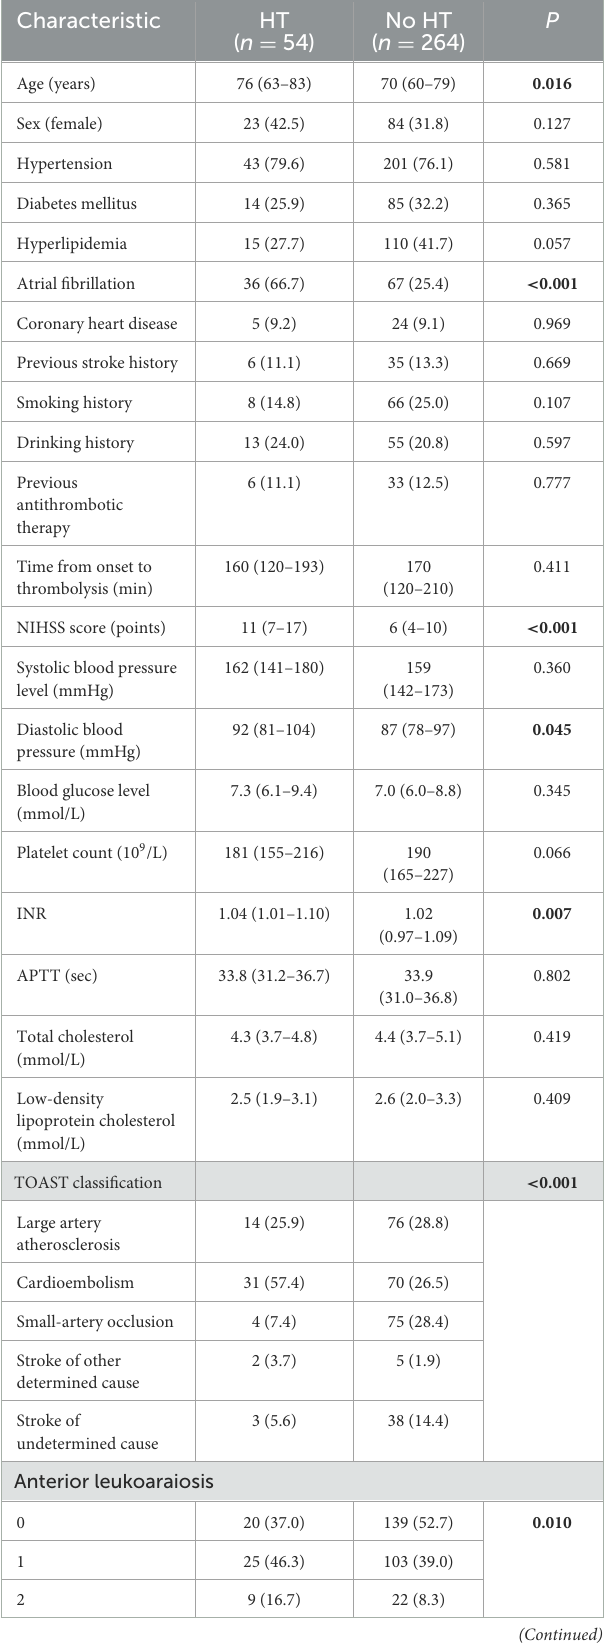
TABLE 1 Clinicodemographic characteristics of acute ischemic stroke patients a